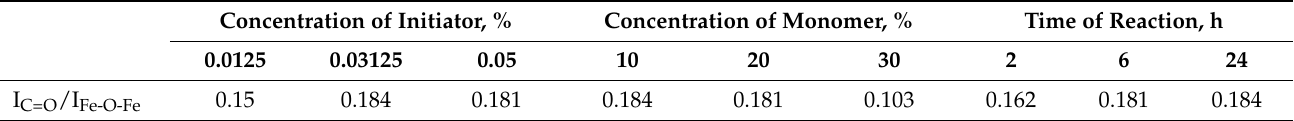
Table 1. Effect of concentration of initiator and monomer; time of the reaction on efficiency of PAA grafting. Concentration of Initiator, % Concentration of Monomer, % Time of Reaction, h 0.0125 0.03125 I C=O /I Fe-O-Fe